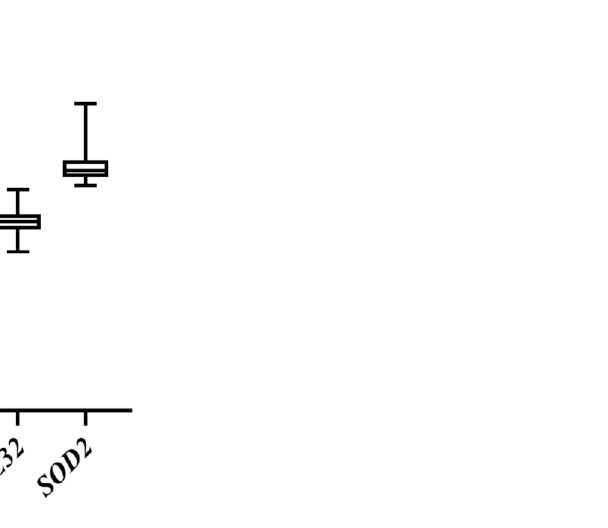
5 of 15 Table 1. Expression stability ranking of the selected candidate reference genes using Delta Ct, geNorm, BestKeeper, NormFinder, and RefFinder. Rank